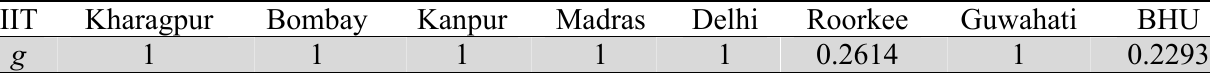
Efficiency scores for IITs IIT